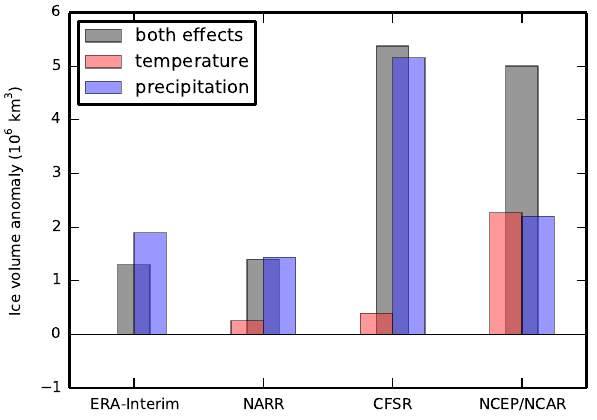
Figure 14. Effect of temperature and precipitation anomalies (sep- arately and jointly) from each reanalysis on modelled final ice vol- ume relative to the result of the WorldClim − 5 ◦ C offset simulation. Corresponding ice sheet geometries are presented in Figs. 7 and